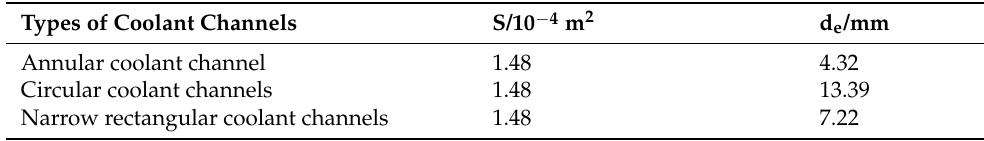
Table 9. Comparison of the equivalent diameters (d e ) of the three coolant channels [29]. Types of Coolant